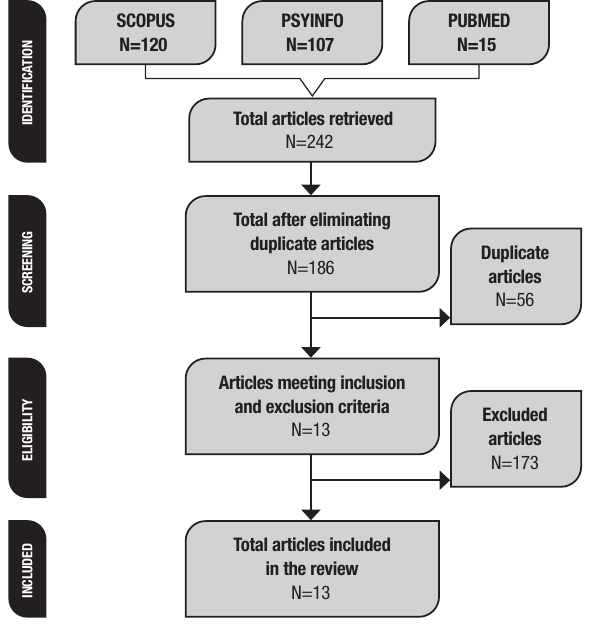
Figure 1. Article screening and